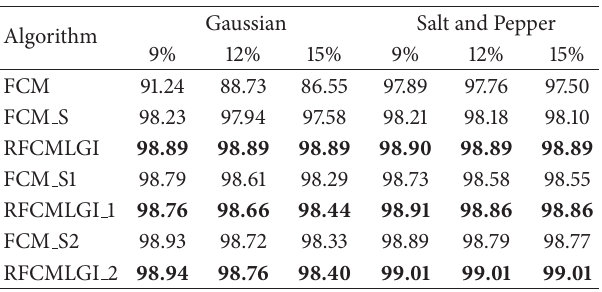
Table 1: Segmentation accuracies (SA, in %) of seven algorithms on synthetic